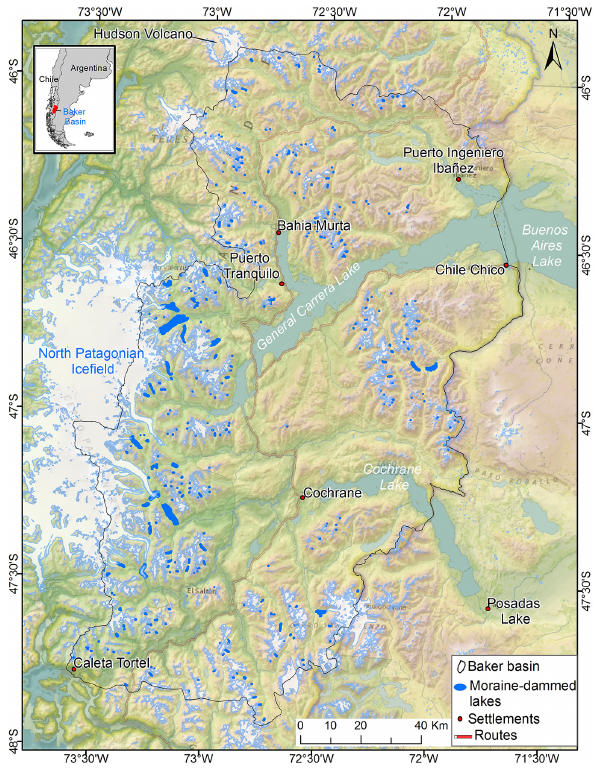
Figure 2. Location of moraine-dammed lakes and settlements in the Baker